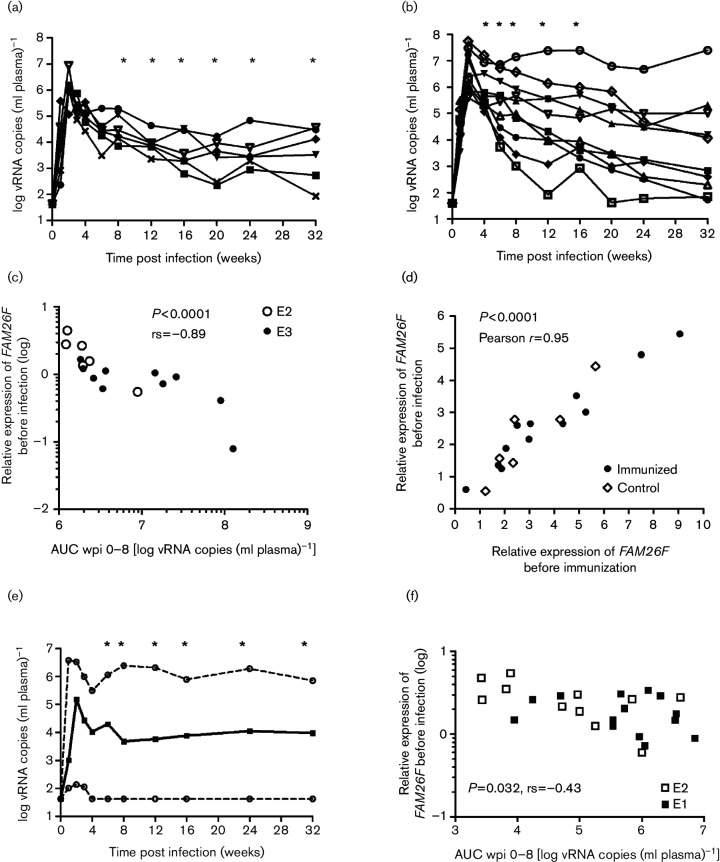
FAM26F gene expression at day of first SIV exposure correlates with the extent of early viral replication. (a) Log plasma viral RNA copies of unvaccinated macaques (n=6) from E2 are shown. Asterisks (*) mark significant correlation of FAM26F RNA levels at day of first SIV exposure with overall plasma viral load from infection to this time point. Significant correlations with overall viral load: AUC 0–8 to AUC 0–20: P=0.033, rs=−0.89; AUC 0–24 and AUC 0–32: P=0.017, rs=−0.94. (b) Log plasma viral RNA copies of unimmunized macaques (n=10) from E3 are shown. Asterisks (*) mark significant correlation of FAM26F RNA levels at day of first SIV exposure with overall plasma viral load from infection to this time point. Significant correlations with overall viral load: AUC 0–4: P=0.02, rs=−0.71; AUC 0–6: P=0.016, rs=−0.73; AUC 0–8: P=0.013, rs=−0.74; AUC 0–12 and AUC 0–16: P=0.029, rs=−0.68. (c) Relative expression of FAM26F in PBMCs at day of first SIV exposure correlated with overall plasma viral load 0–8 wpi in non-immunized macaques from two independent experiments (AUC wpi 0–8: E2: rs=−0.88, P=0.033, n=6; E3: rs=−0.74, P=0.013, n=10); P value and Spearman's correlation coefficient rs for the combined data set are shown in the figure. (d) Correlation of individual relative FAM26F RNA levels in PBMCs before immunization with those of day of first SIV exposure 10 months later in immunized (n=12) and unvaccinated control macaques (n=6). Significance and Pearson r are indicated in the figure. (e) Log plasma viral RNA copies of unvaccinated macaques (from E1 and E3, n=25) are shown as median (solid line) and upper and lower range (dashed lines). Asterisks (*) mark significant correlation of FAM26F RNA levels at day of first SIV exposure with overall plasma viral load from infection to this time point. Significant correlations with overall viral load: AUC 0–6: P=0.036, rs=−0.42; AUC 0–8: P=0.032, rs=−0.43; AUC 0–12: P=0.017, rs=−0.46; AUC 0–16: 0.017, rs=−0.48; AUC 0–24: P=0.014, rs=−0.45; AUC 0–32: P=0.029, rs=−0.43). (f) Relative expression of FAM26F in PBMCs at day of first SIV exposure correlated with overall plasma viral load 0–8 wpi (AUC wpi 0–8) in macaques from two experiments (E1, E2) immunized with an experimental AIDS vaccine (n=25). P value and Spearman rank correlation coefficient (rs) are shown.